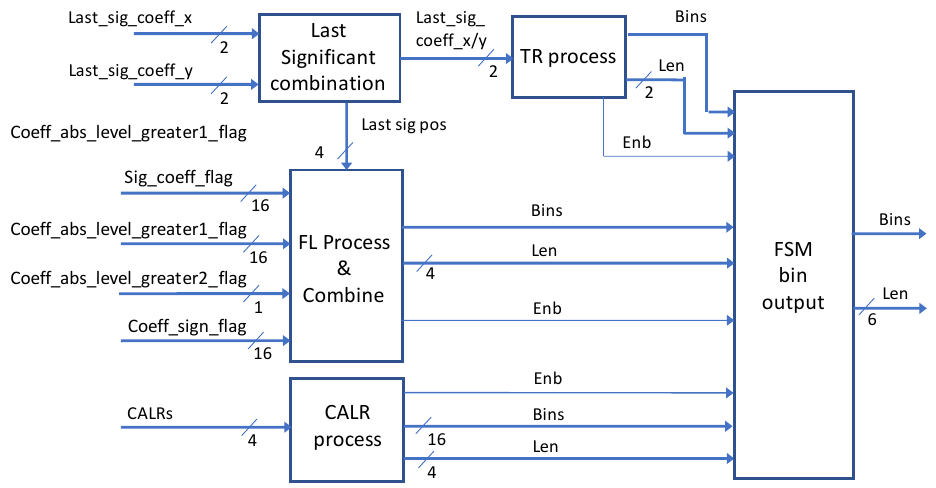
Figure 9. Hardware architecture of residual binarizer.